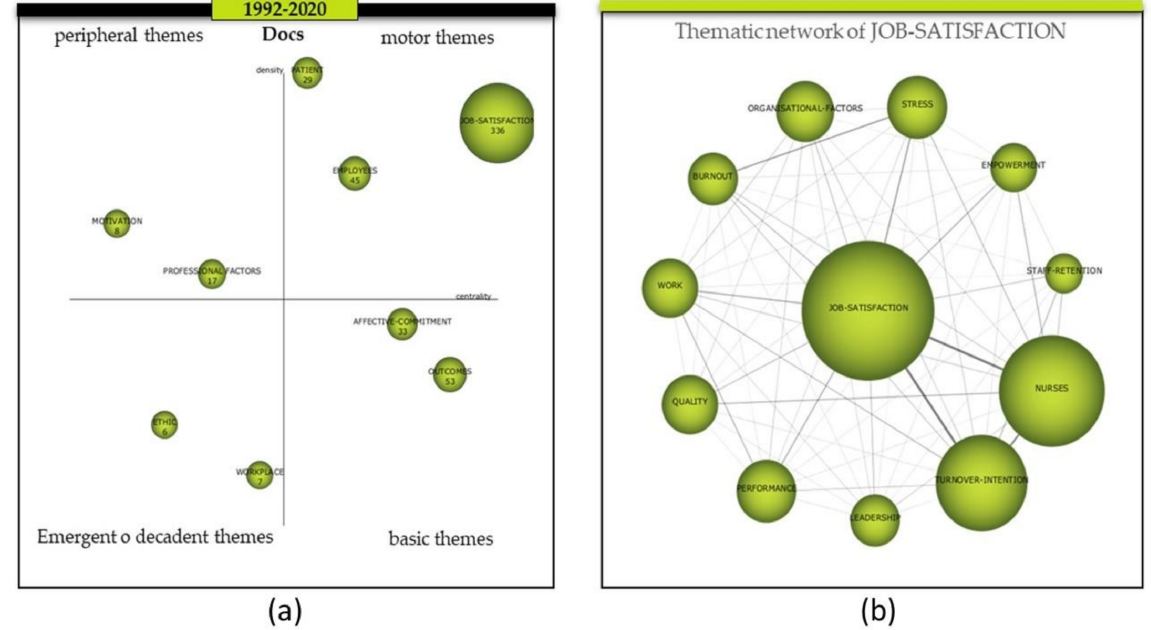
Figure 2. Evolution of the themes period 1992–2020 and thematic network of the cluster job-satisfaction. ( a ) Evolution of the themes period 1992–2020. ( b ) Thematic network of the cluster job-satisfaction. Source: Prepared by the authors on the basis of SciMAT data.